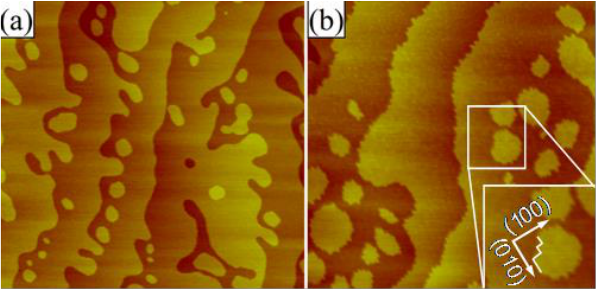
Table 2. Deposition parameters for the MeO (Me = Ti, Sr, Ba) thin films. T d = deposition temperature, P d = deposition pressure (O 2 gas), E d = laser energy density on target, f = laser repetition rate, d ts = substrate – target distance.